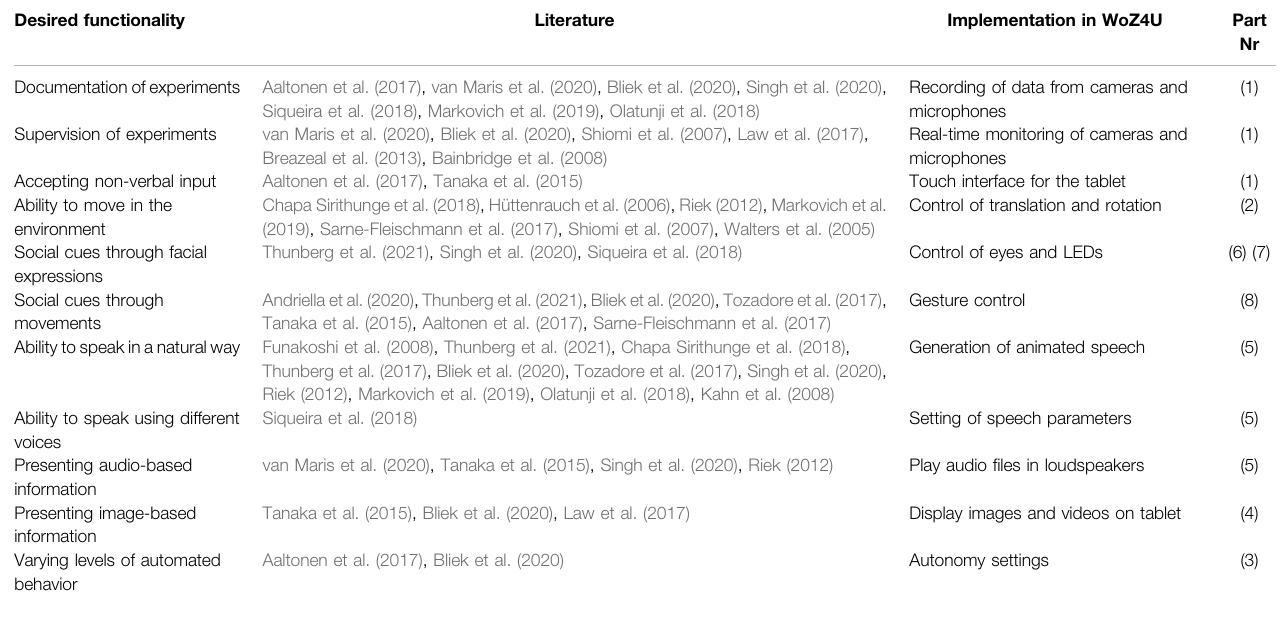
TABLE 1 | A summary of desired robot functionalities found in the literature, how this is provided in WoZ4U, and the corresponding part number introduced in Figure 3 . Desired functionality Literature Implementation in